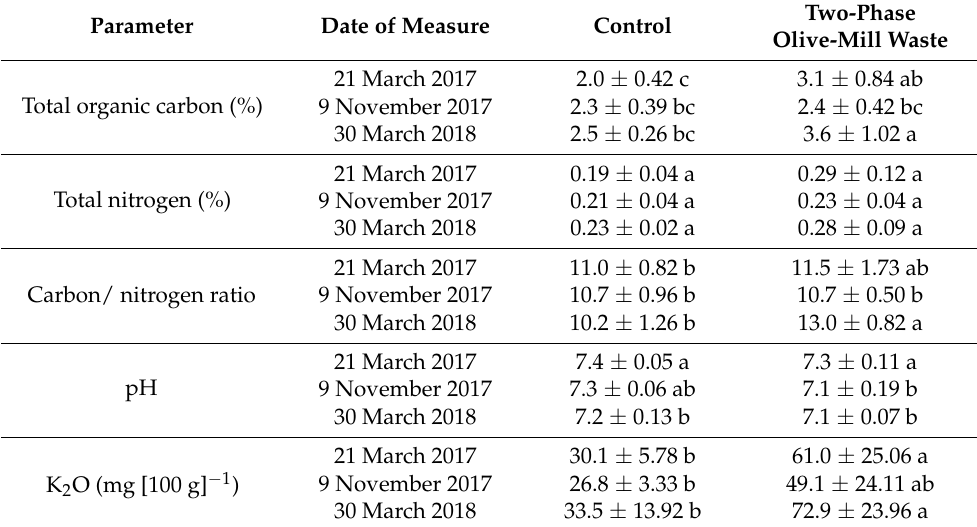
Two-Phase Olive-Mill Waste